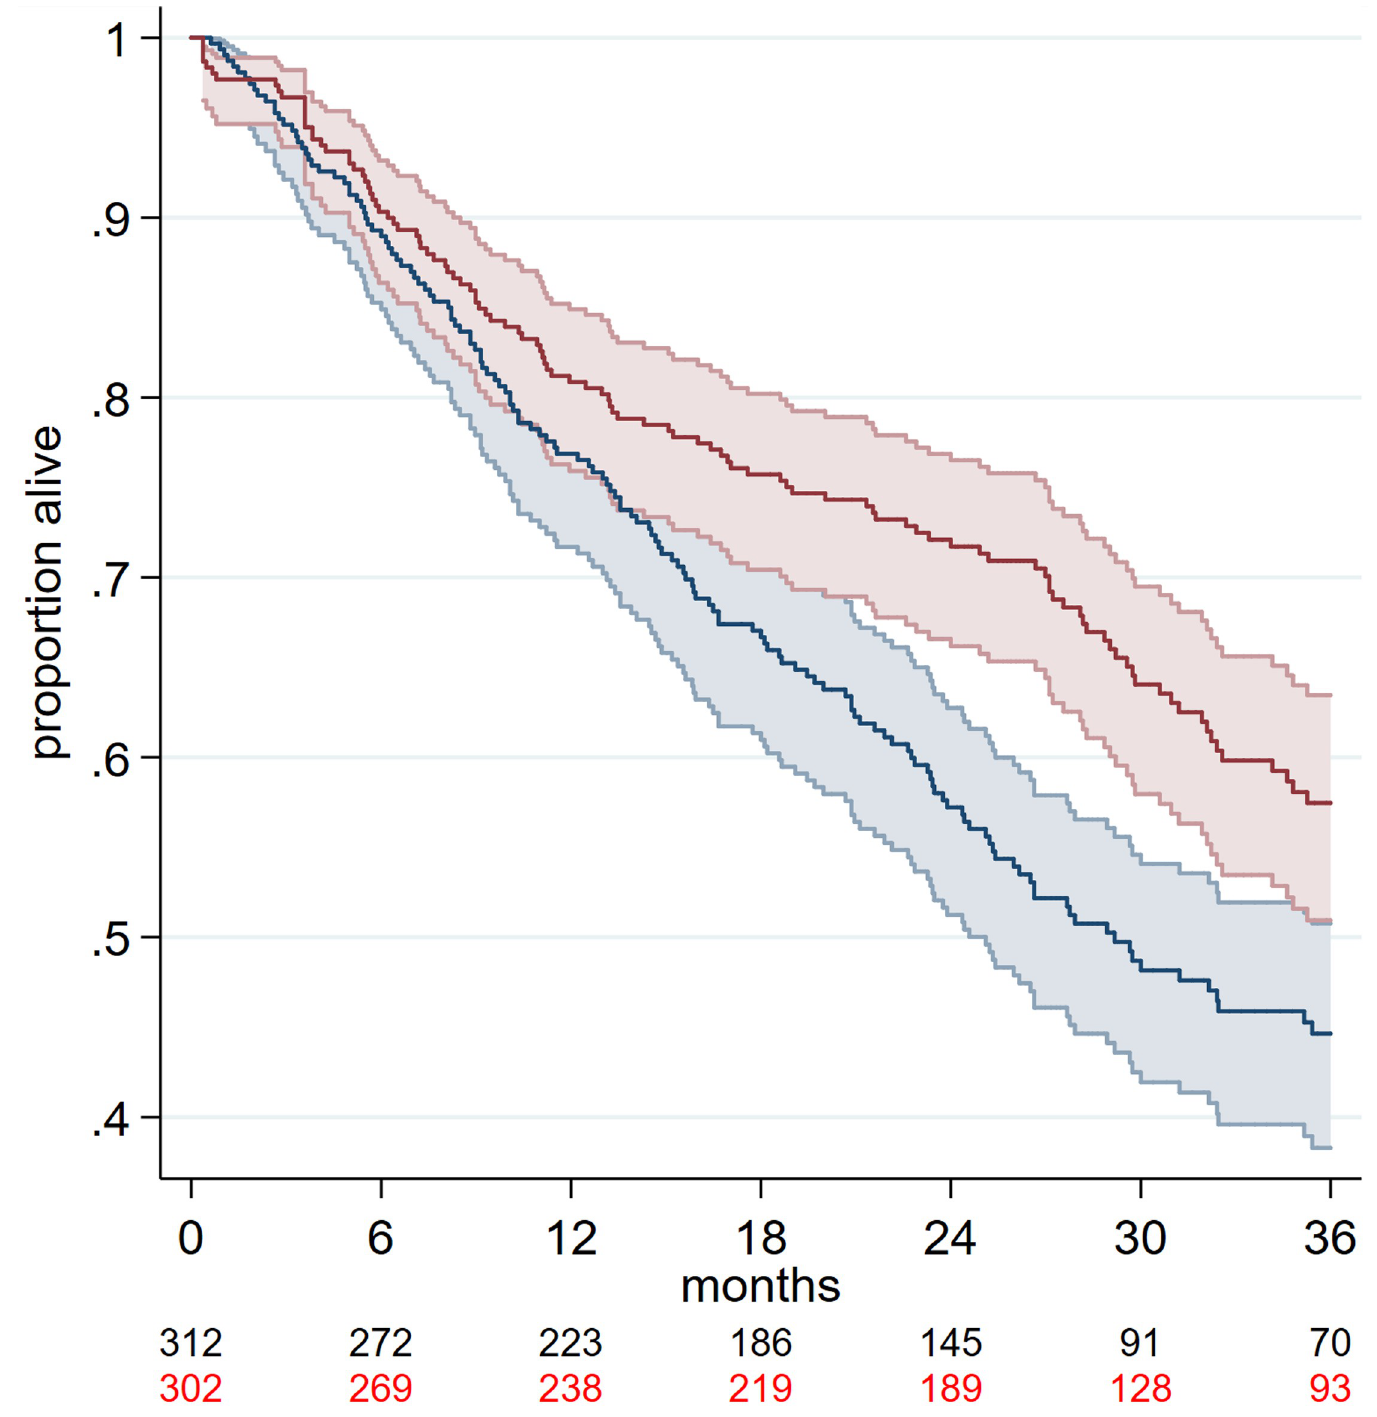
Fig 1. Reconstructed KM plots with 95% CIs for 3-year survival in COAPT. Red represents the PR+GDMT arm and black represents GDMT